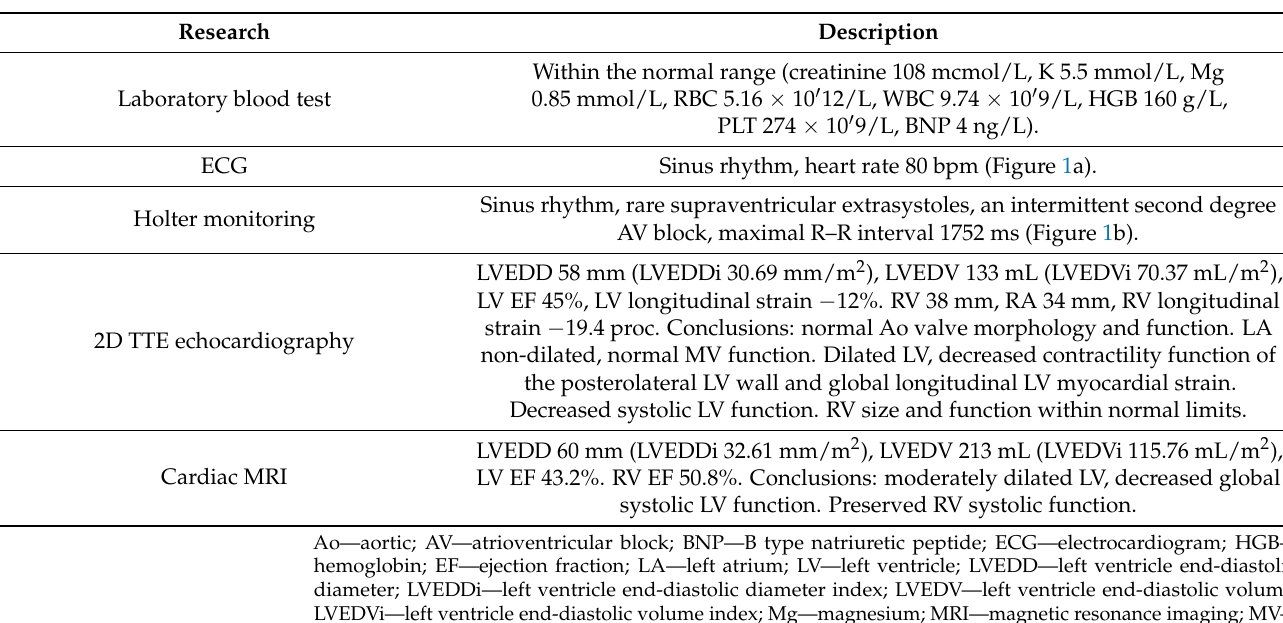
Figure 2. Left ventricular global longitudinal strain by speckle-tracking echocardiography. Two-dimensional TTE and Holter monitoring were repeated at follow up after 3 months of the discontinuation of active sports and protein intake. Persistently decreased LV systolic function was observed, with no evidence of arrhythmia or conduction abnormalities.